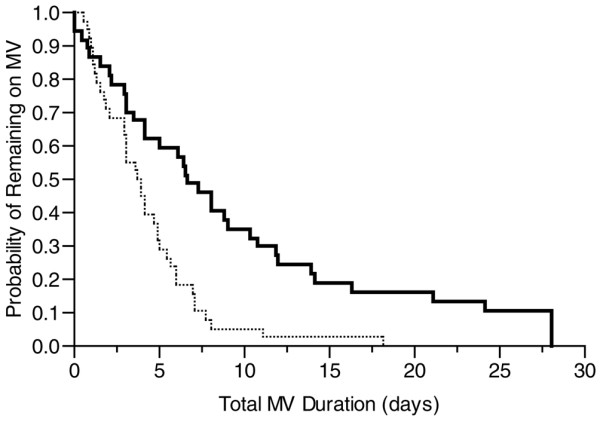
Kaplan-Meier survival curve of total duration of mechanical ventilation (MV) for patients treated by daily interruption of sedation (thick line) and sedation algorithm (thin line) (P = 0.0003).